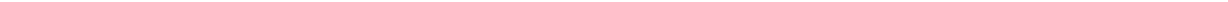
Fig. 5 Misalignment with environmental LD cycles disrupts cardiac rate and leads to long QT interval. a Incomparison to matched 24 h LD cycle housed mice, mean heart rate (HR) was signi fi cantly reduced in mice maintained in 22.5 and 27 h LD cycles, which was accompanied by a signi fi cant reduction in the amplitude of HR rhythms in the 27 h LD mice. b HR remained signi fi cantly reduced in non-24h LD housed mice even when analyses were limited to periods of inactive (no recorded movement for 20 min preceding HR measure). c Murine ECG beat waveform with de fi ning features labelled. d – h Diurnal pro fi les and mean interval durations for RR ( d ), PR ( e ), QRS ( f ), QT ( g ) and RR-adjusted QT (QTc; h ) of mice maintained under 24 h, 22.5h or 27 h LD conditions. All parameters were signi fi cantly lengthened under non-24 h LD cycles. i , j A 2 h light pulse (LP, red ) from ZT14-16 caused a signi fi cant reduction in night-time HR when compared with the average HR pro fi le recorded over three preceding cycles ( blue , NLP). k – m Complete autonomic blockade (AB) increased HR at ZT2 (~2 h after lights on; k ) and ZT14 (~2 h after lights off; l ) in 22.5 h LD housed mice, and normalised it to 24 h LD conditions. m Change in HR (vs. baseline) during autonomic blockade at ZT2 and ZT14. Diurnal pro fi les depict mean ± 95%CI. ∗ p < 0.05, ∗∗ p <